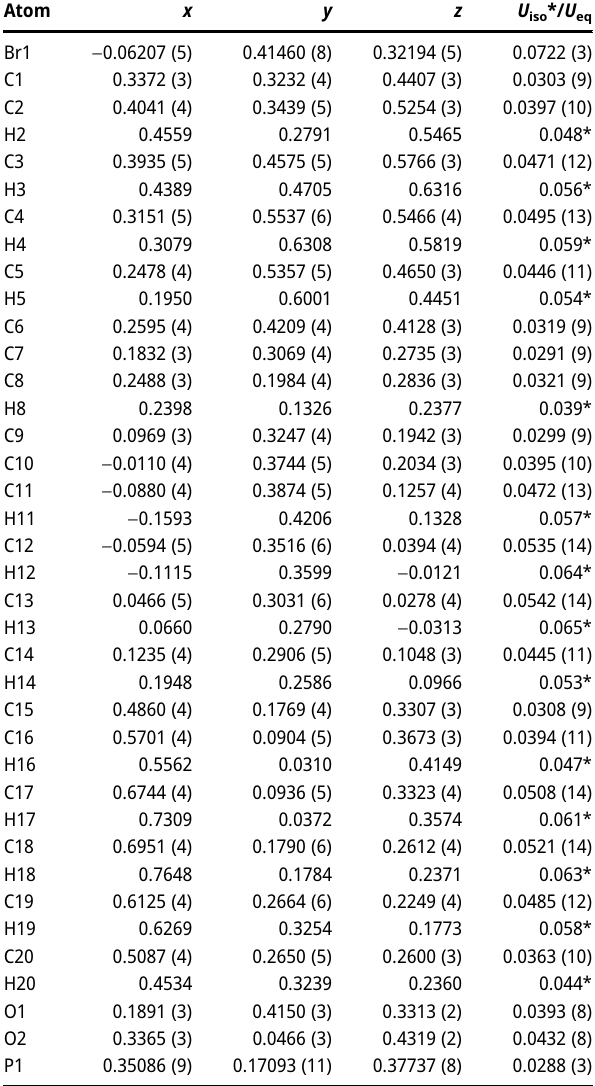
Table  : Fractional atomic coordinates and isotropic or equivalent isotropic displacement parameters (Å 